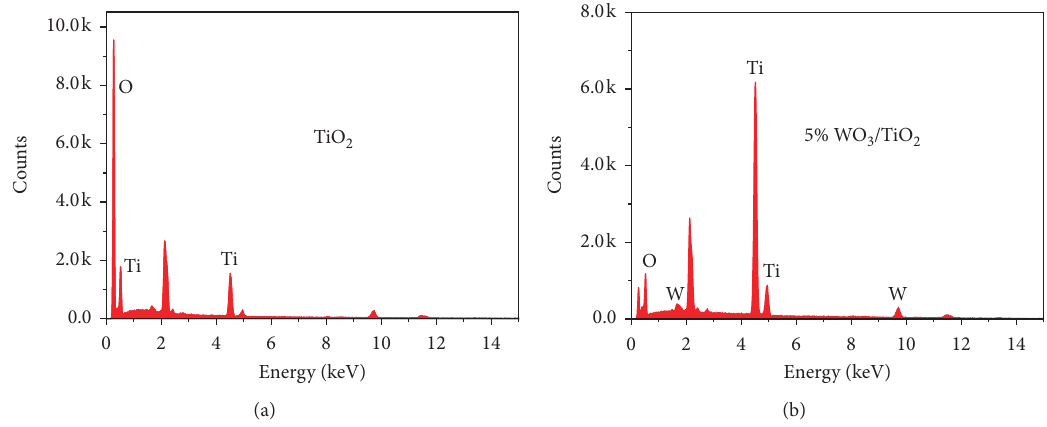
Figure 6: EDS of TiO 2 (a) and 5% WO 3 /TiO 2 (b) nanofibers.